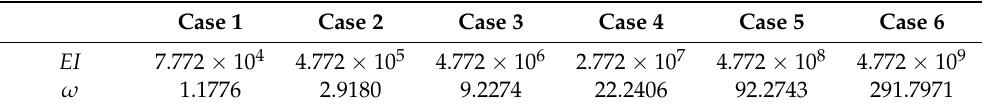
Table 3. Bending stiffness and natural vibration frequency of foundation under different conditions (s = 22.1746).